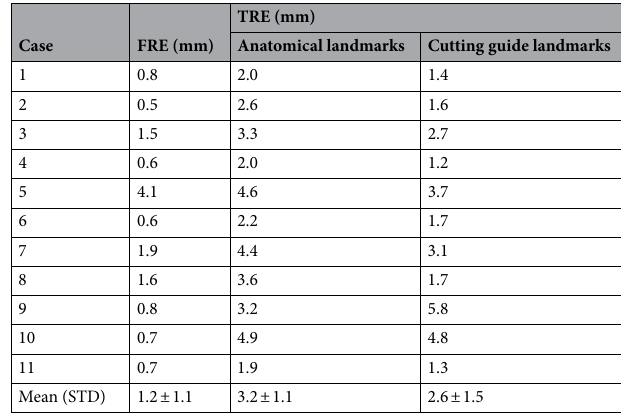
Table 2. The accuracy measures for the registration (fiducial registration errors, FRE) and the navigation procedure (target registration errors, TRE). FRE fiducial registration error, TRE target registration error, STD standard deviation.